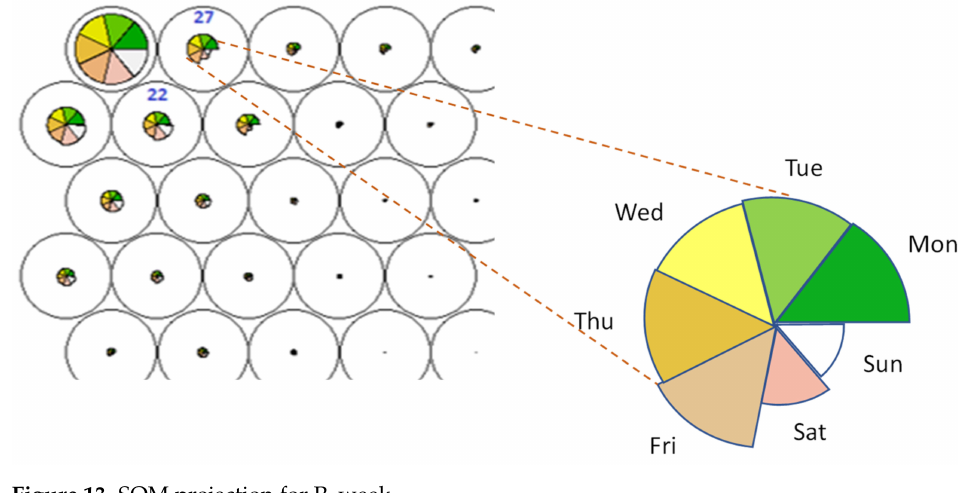
Figure 13. SOM projection for P_week.